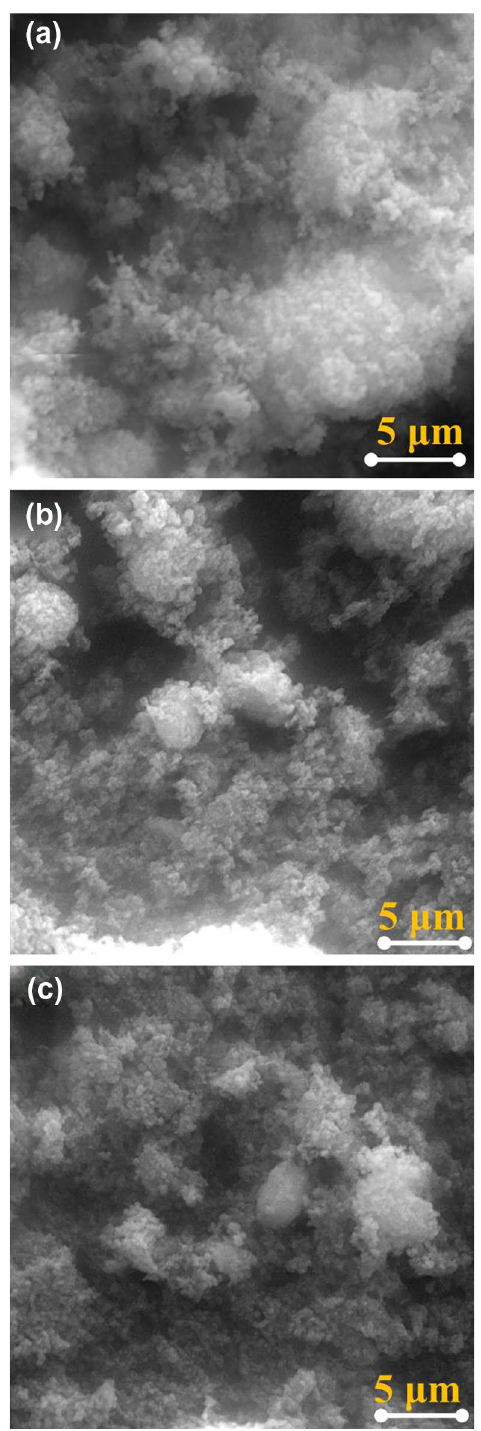
Figure 2. The SEM images of the ZnO powders before ( a ), and after irradiation with laser having wavelength of 1064 nm ( b ), and 532 ( c